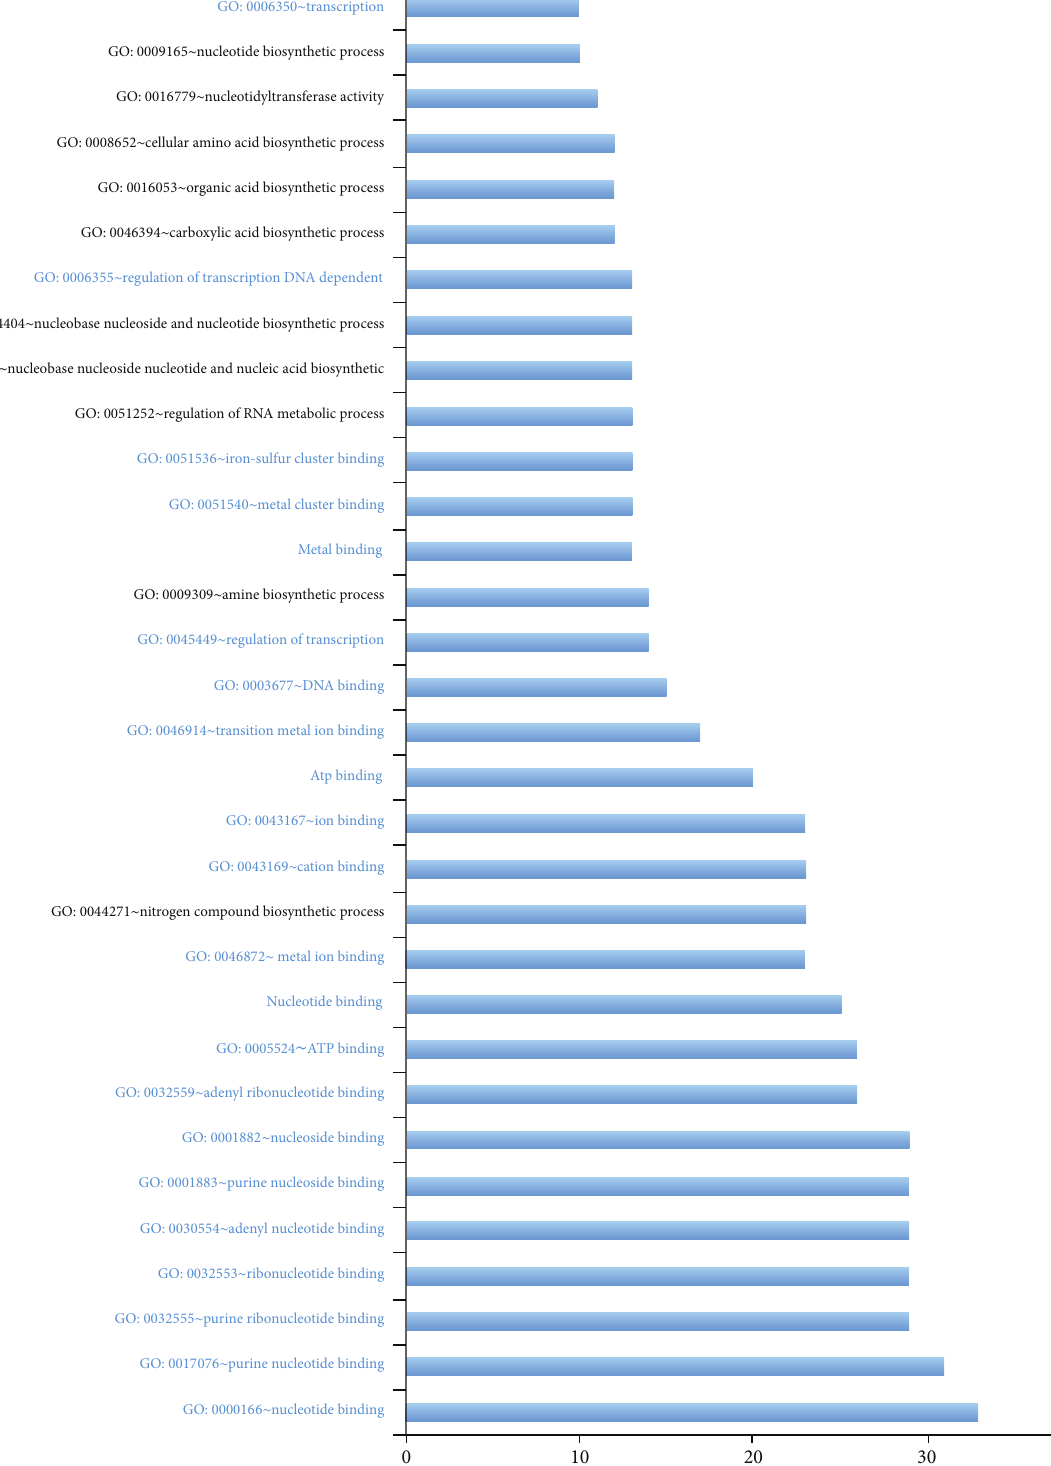
Figure 2: Bar chart shows the functional enrichment analysis results using DAVID. The length of the bar indicates the frequency of terms appearing in the description of functional enrichments ( > 10). Terms related to transcriptional regulation are indicated in